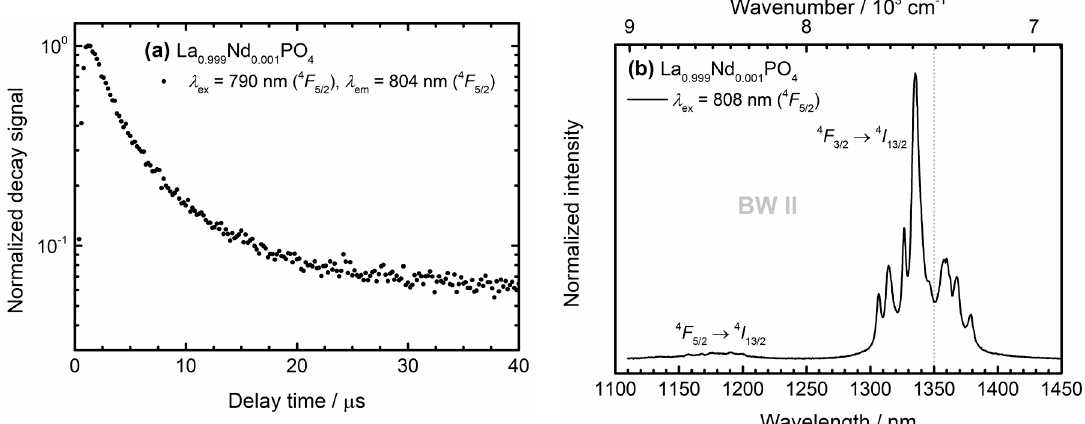
Figure 7. ( a ) Detailed view on the fast decay component from the 4 F 5 / 2 spin-orbit level of Nd 3 +